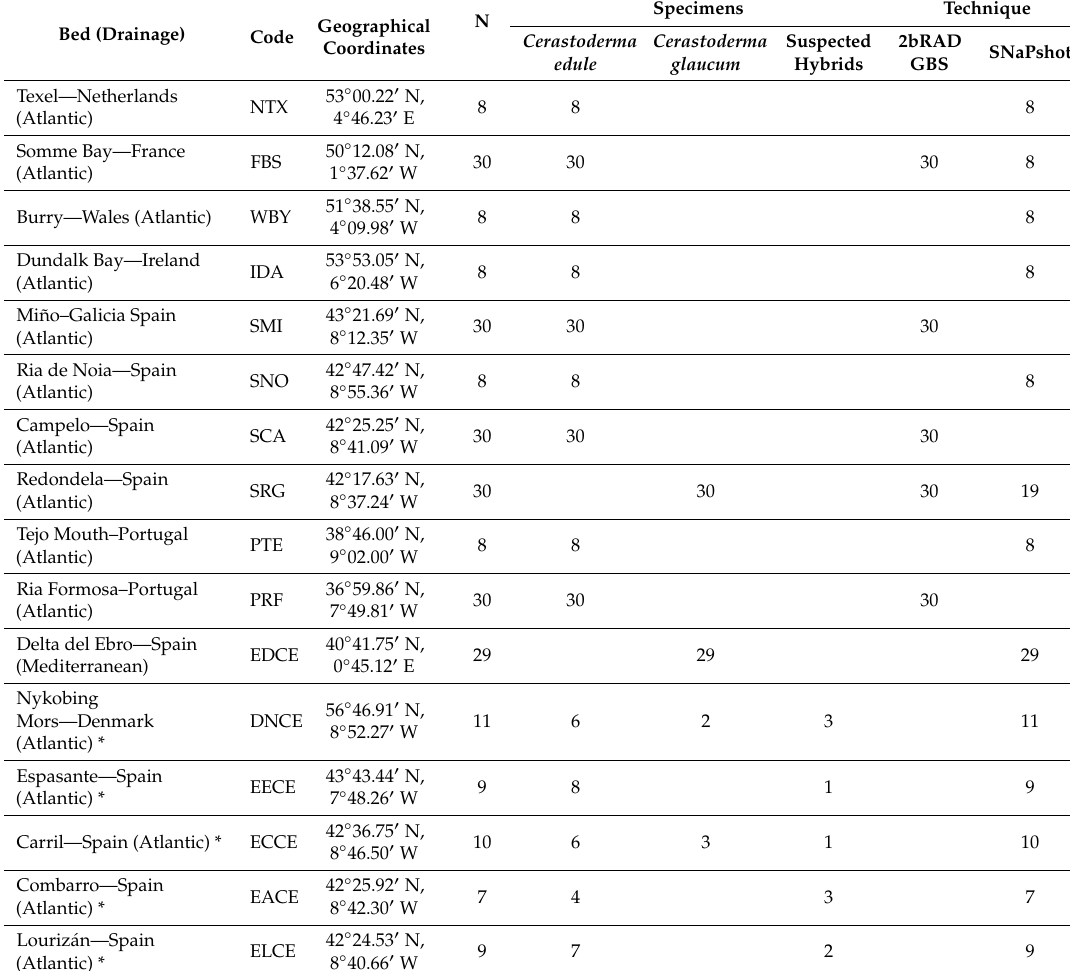
Table 1. Cockle beds used in the present study. Individuals used for genomic libraries for 2b restriction site-associated DNA sequencing genotyping by sequencing (2b–RAD GBS) and those analyzed with the SNaPshot molecular tool (SNaPshot) developed in the present study are